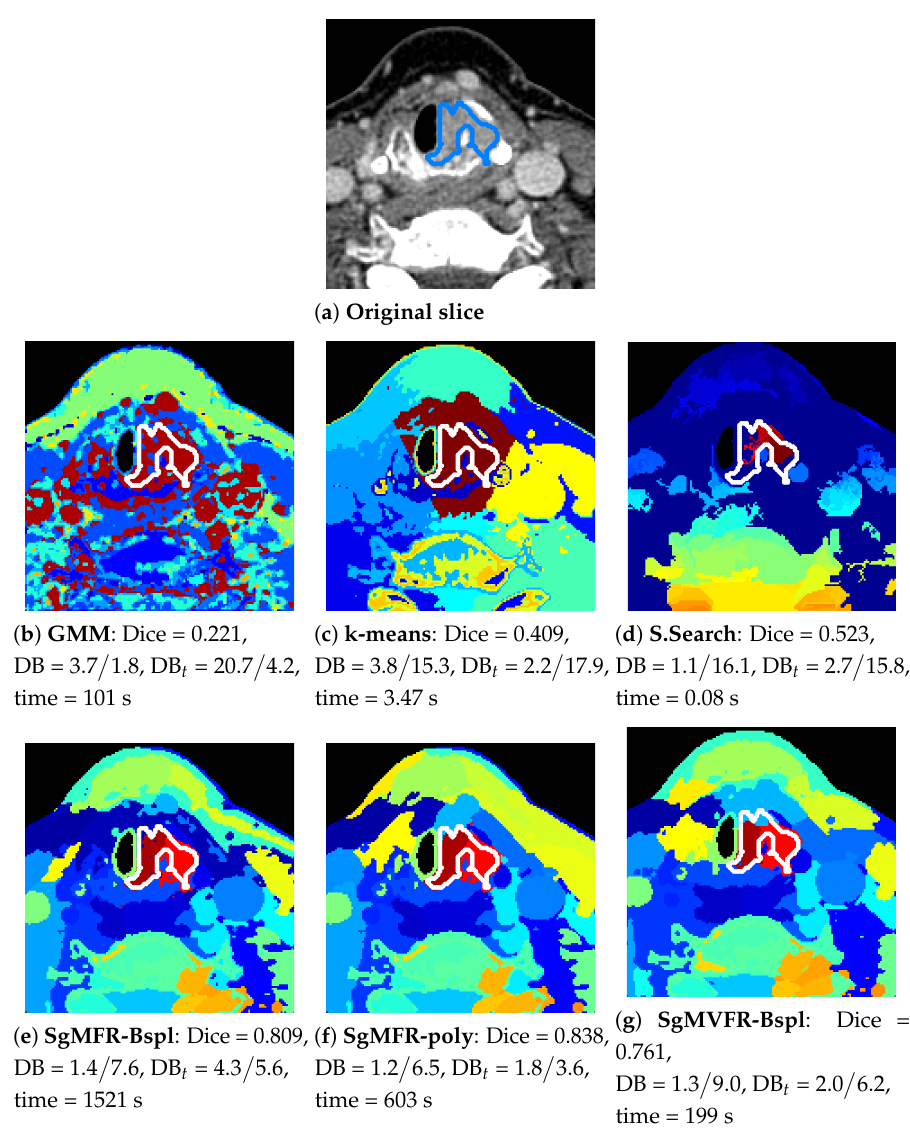
Figure 2. Clustering results for each approach in one tumor (DB ( t ) = spatial/spectral index). Our proposed approaches are on the bottom row. One random color is assigned per cluster, ground truth tumor contour is in blue ( a ) or white ( b – g